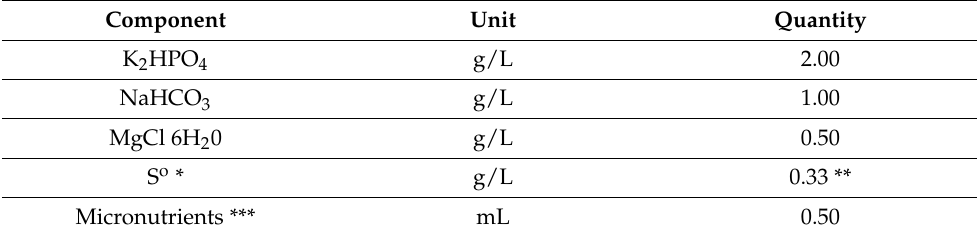
Table 3. Composition of synthetic wastewater in sequential aDN Table 3 . Composition of synthetic wastewater in sequential aDN process.